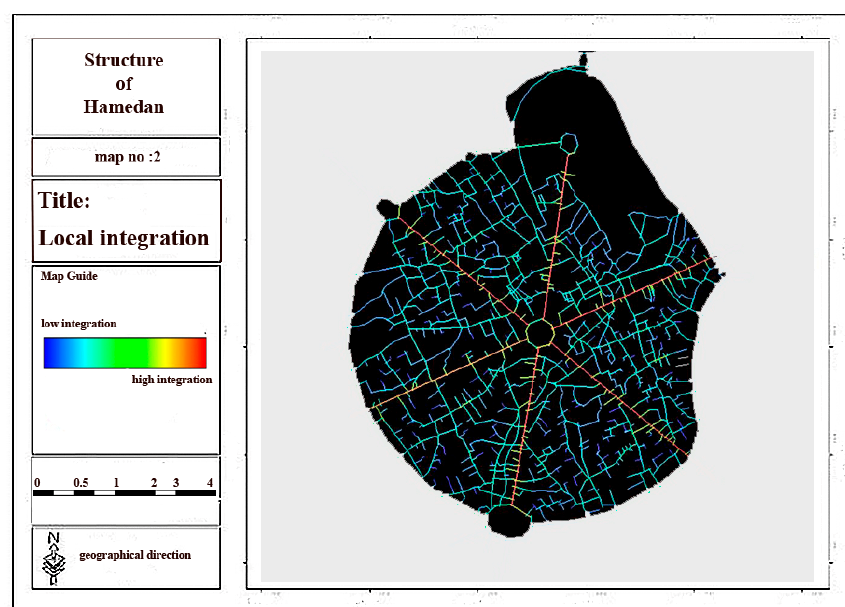
Figure 5. Local integration of the main structure of city .